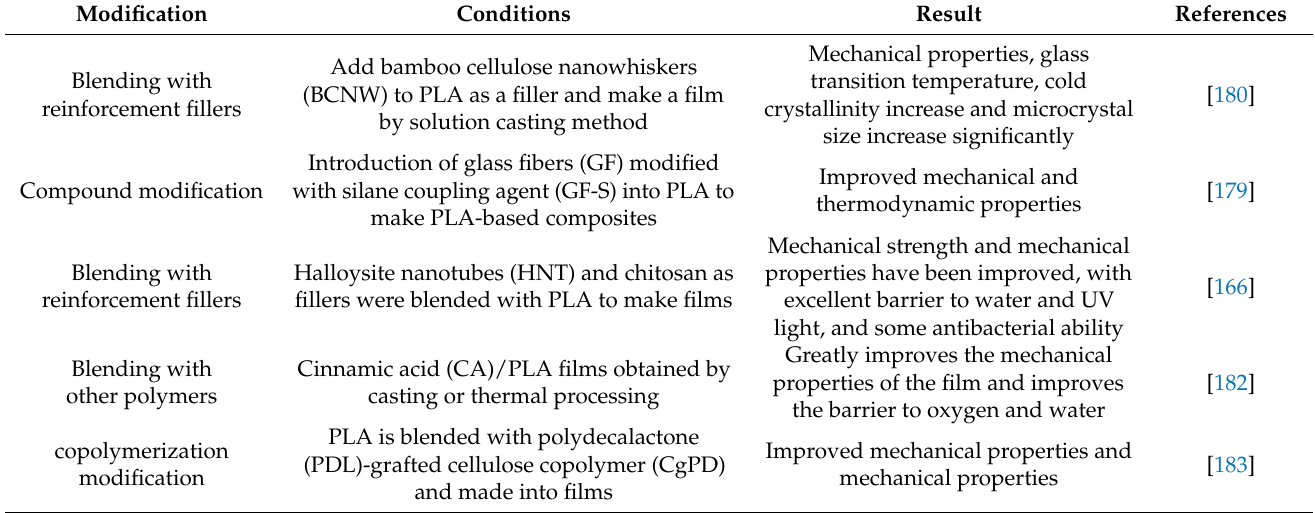
Table 11. The different modifications of PLA film